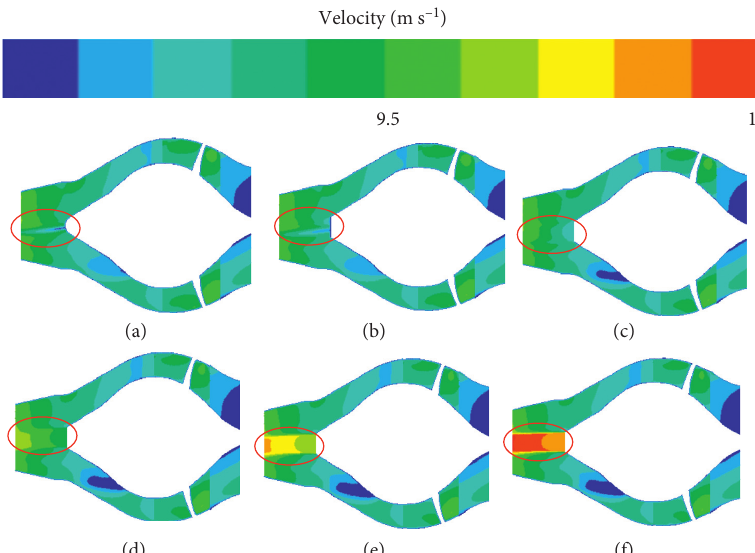
Figure 10: The velocity distribution cloud diagram of the longitudinal section of the pump section. (a) Original device, (b) v � 8, (e) v � 12, (f) v � 16 (m s − 1 (d) v jet jet jet